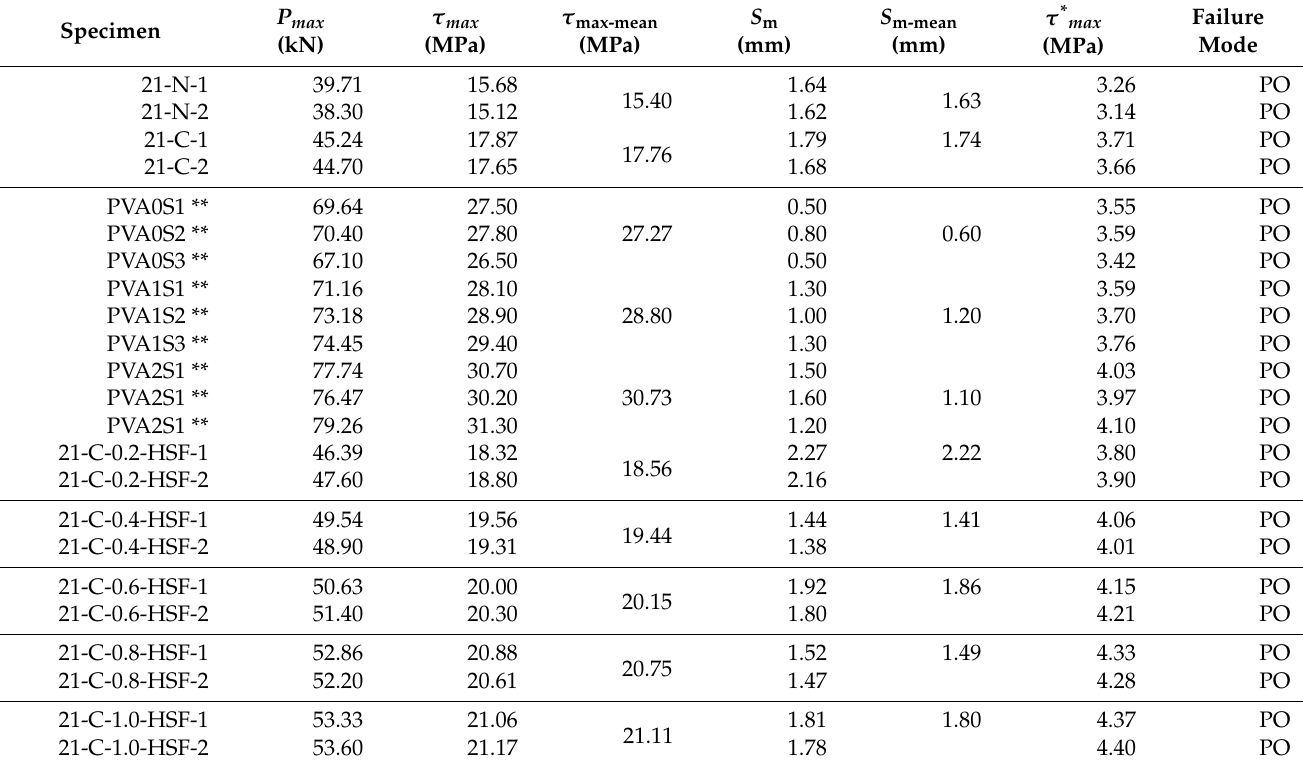
Table 5. Experimental results for pullout test